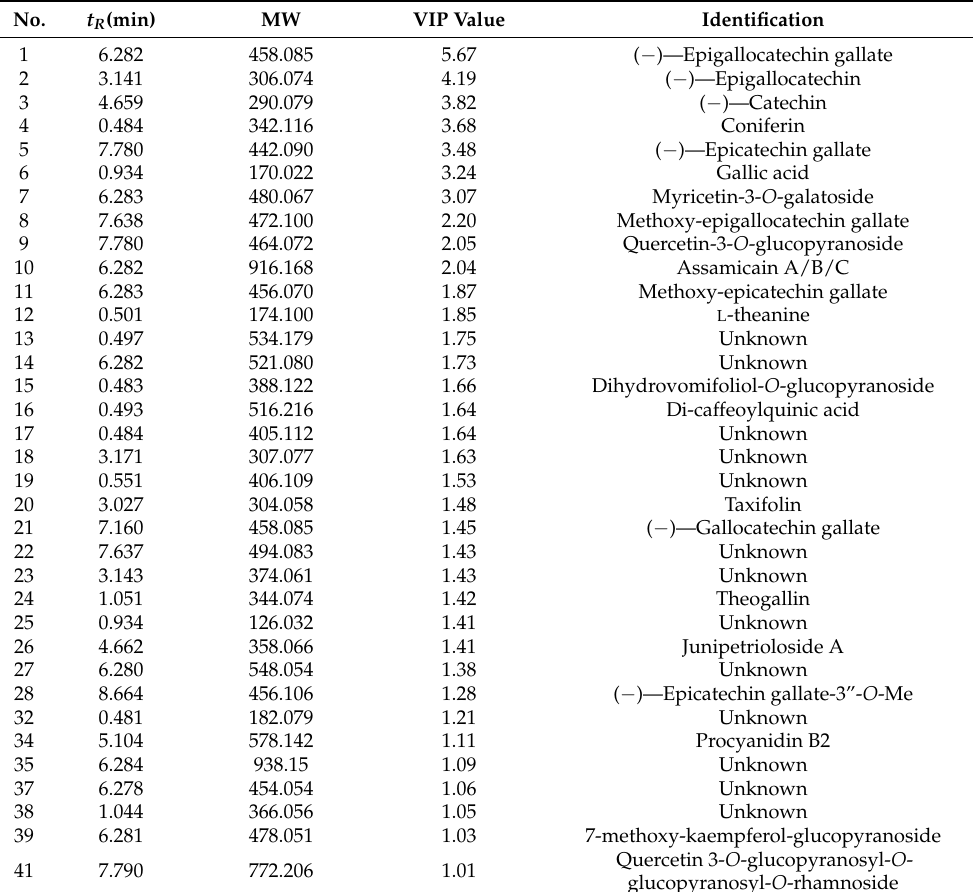
Figure 3. Metabolomics analysis of QZT samples from different processing stages. ( A ) Scatterplots based on OPLS-DA analysis between the two categories of QZT samples. ( B ) S -plots based on OPLS-DA analysis between the two categories of QZT samples. Table 3. The critical compounds responsible for the classification of QZT samples from different processing stages.